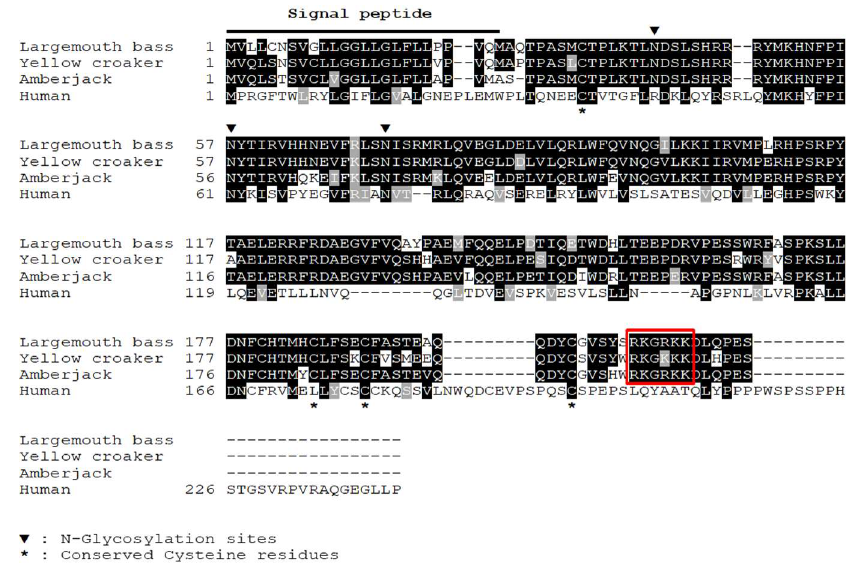
Figure 1. Amino acid sequence alignment of largemouth bass (LMB)-IL-34 in this study with reference IL-34s deposited in NCBI. The line above the alignment presented the signal peptides, the N-glycosylation sites are indicated by a triangle above the alignment, the conserved cysteine residues are indicated by a star below, and the lysine/argine rich motifs (RKG[R/K]K) are shown in the red box.